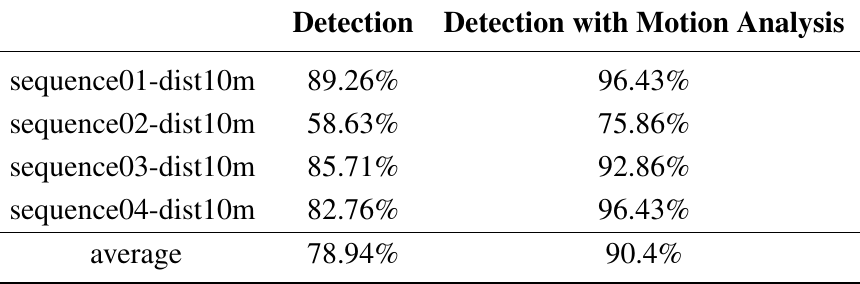
Table 5. Mean value of correct first detections at distances up to 10 m.